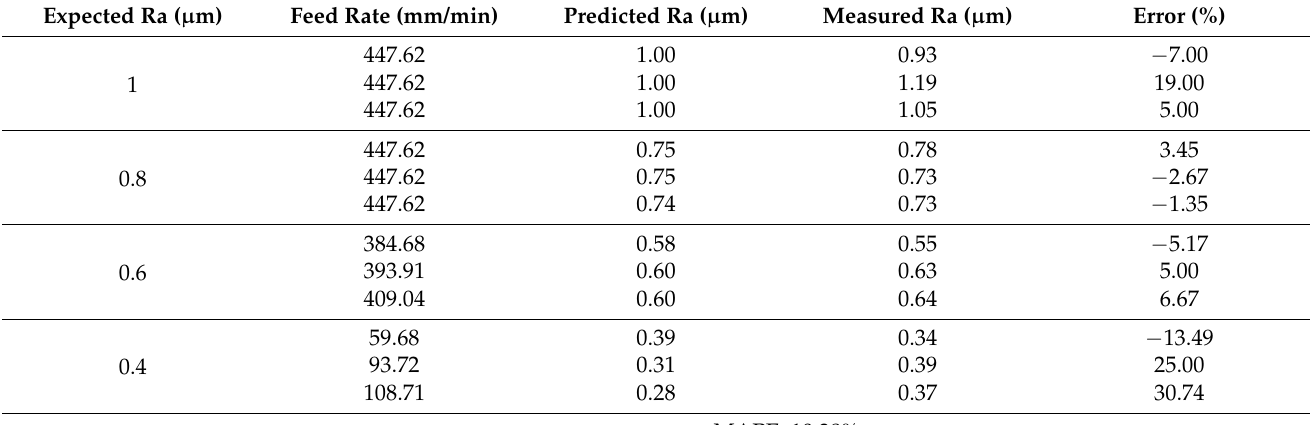
Table 8. Experiment results by using the selected optimal combinations of cutting parameters. Expected Ra ( µ m)